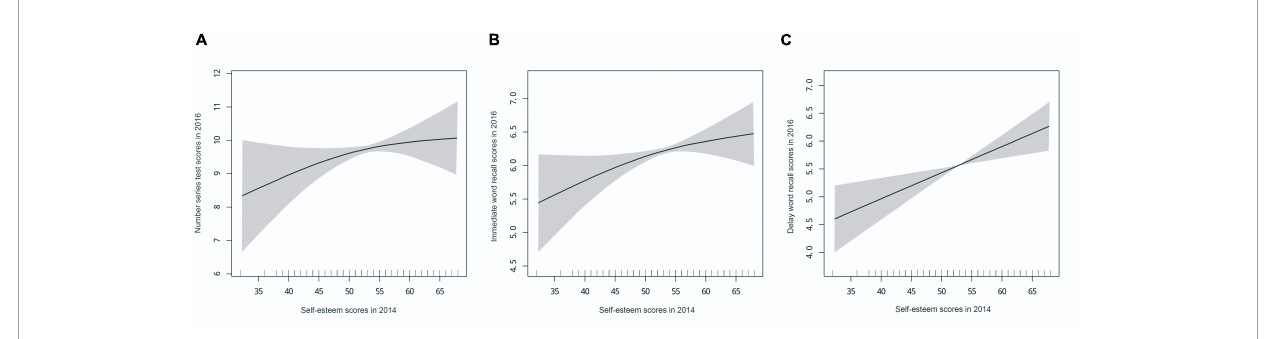
FIGURE3 The association of self-esteem in 2014 with cognitive test scores in 2016. (A) Association of self-esteem scores in 2014 with number series test scores in 2016. (B) Association of self-esteem scores in 2014 with immediate word recall scores in 2016. (C) Association of self-esteem scores in 2014 with delay word recall scores in 2016. Adjusted for adolescents’ characteristics (age and gender), parents’ characteristics (maternal age, paternal age, maternal education level, paternal education level, maternal employment status, paternal employment status), and household characteristics (urban–rural location, household per capita income, family size). Solid lines represent the spline curve, and the shaded areas represent the 95% confidence interval of the spline